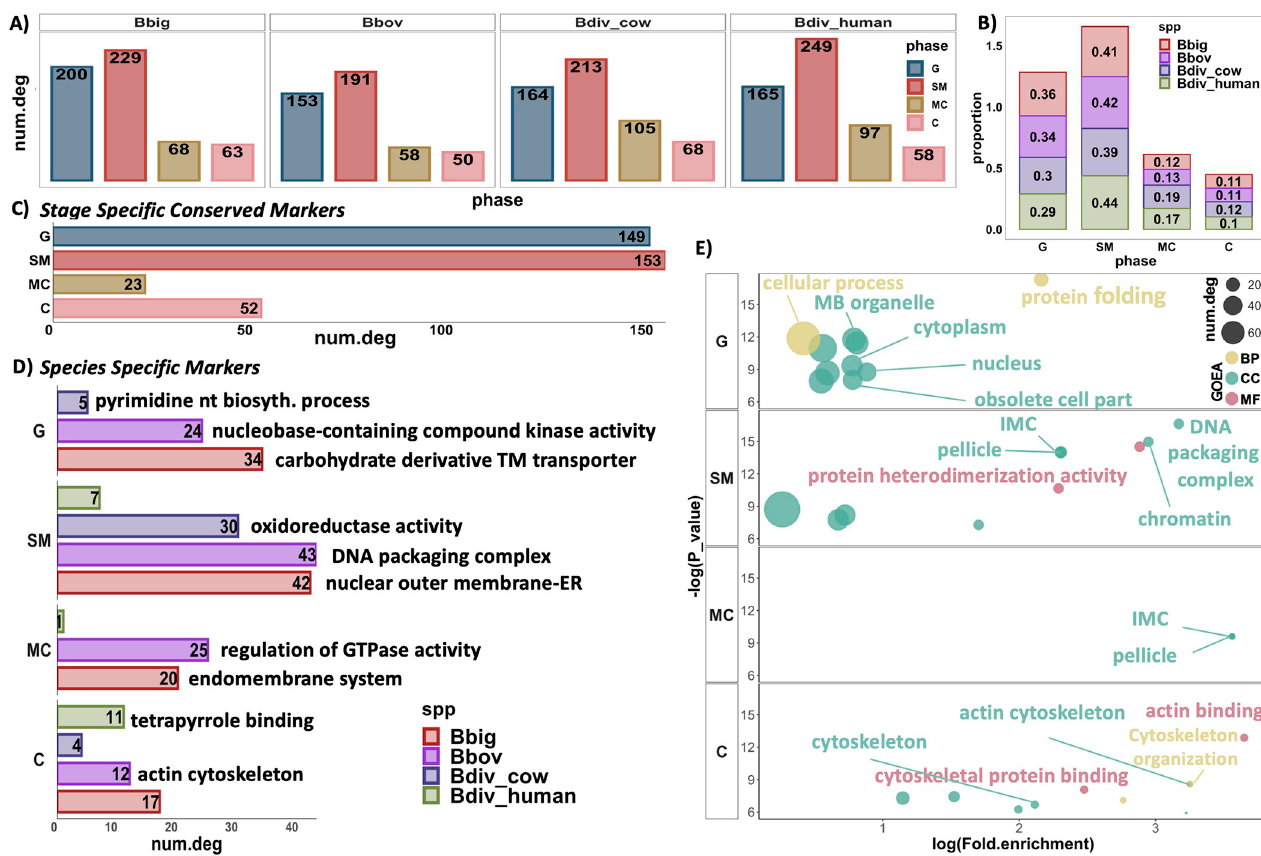
Fig 4. Differential expression and Gene Ontology enrichment analysis (GOEA). (A) Total number of inferred replication cycle differentially expressed genes (DEGs) in each species independent of other species. (B) Stack bar plot showing proportion of DEGs in each phase in all species. (C) Bar plot showing the total number of conserved DEGs of inferred replication cycle phases (rows) across all species. (D) Total number of DEGs of the indicated phase unique to the indicated species (colors). The most significant Gene Ontology (GO) term (Benjamini < 0.1) associated with the set of DEGs (each bar) is presented next to the bar. (E) Significant GO terms associated with conserved DEGs of the indicated phase (rows). Colors indicate the GO term category. Fold change > 2 and adjusted p -value < 0.01 were applied as cutoffs for all DEG analyses performed in this section. Note: All significant DEGs and GO hits can be found in S3 and S4 Tables. Data and code for generating the figure are available at https://github.com/umbibio/scBabesiaAtlases.